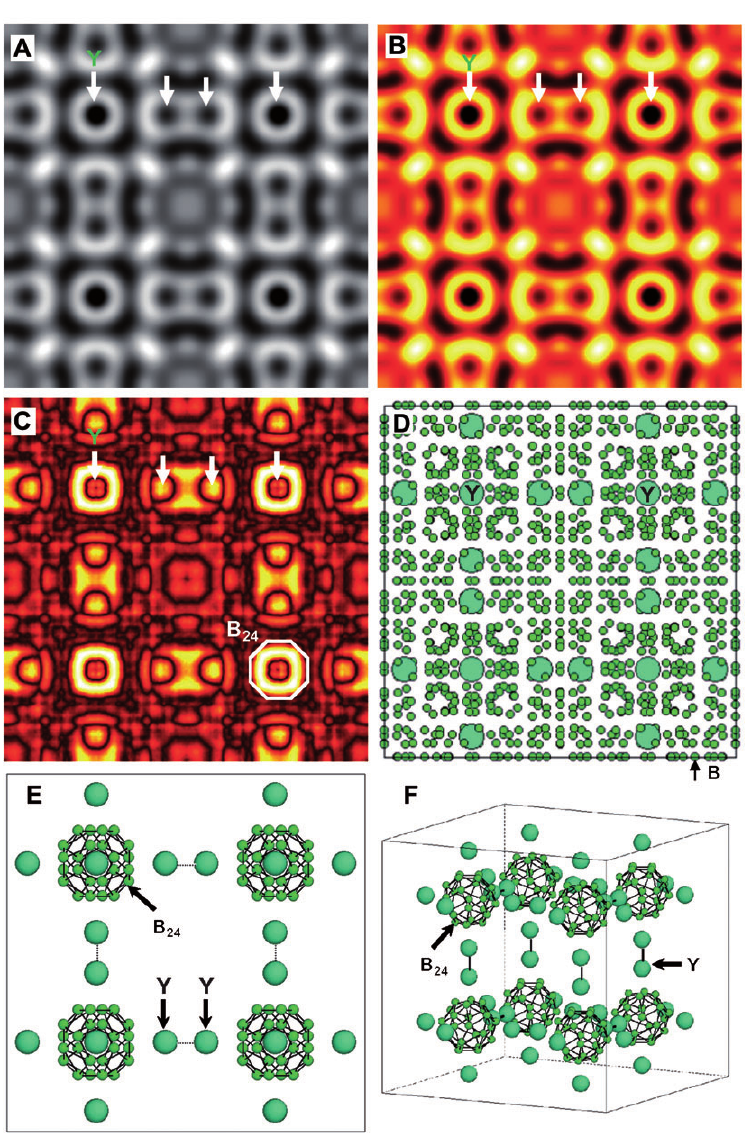
Figure 9 (A) Observed image, (B) calculated image, (C) difference image of (A) and (B), and (D) structure model of YB clusters (Y-holes with B clusters). (F) Three-dimensional projection of Y-B [100] direction. Structure model of (E) Y-B 24 24 (JEM-4000EX, 400 kV). The left side of the image is the thin- nest region of the YB crystal. A unit cell of YB is indicated 56 56 by white lines. The Fourier transform of Figure 11A is shown in Figure 11B. An open circle indicates the resolution limit of the electron microscope of 0.16 nm (JEM-4000EX). Figure 11C is an electron diffraction pattern of YB recorded along 56 the [100] direction; 72 independent refl ections were obtained. The amplitudes corresponding to 0.08 nm were also estimated, indicating a higher resolution than that of the HREM image.